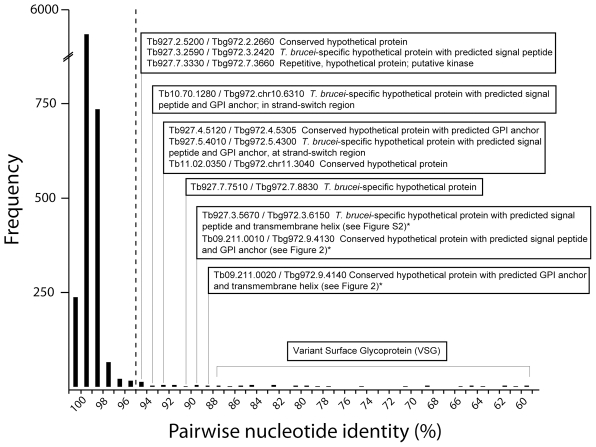
Frequency distribution of pairwise sequence divergence between 6929 single-copy gene orthologs in T. b. brucei and T. b. gambiense.Divergence values to the right of the dashed line are statistically significant; the identities of selected divergent gene pairs are noted. An asterisk * denotes genes belonging to a T. b. brucei subspecies-specific tandem gene array (see Figure 2 and Supplementary Figure S2).